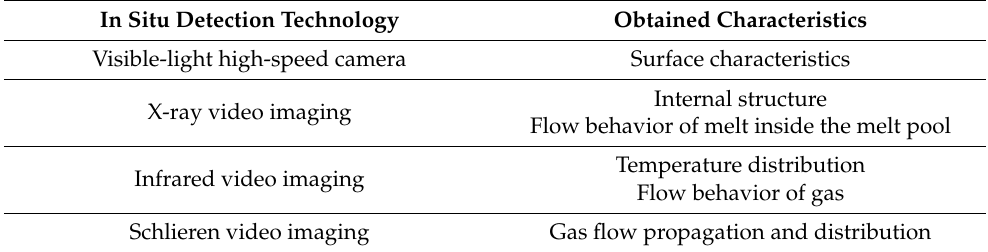
Table 1. Characteristics obtained from different in situ detection